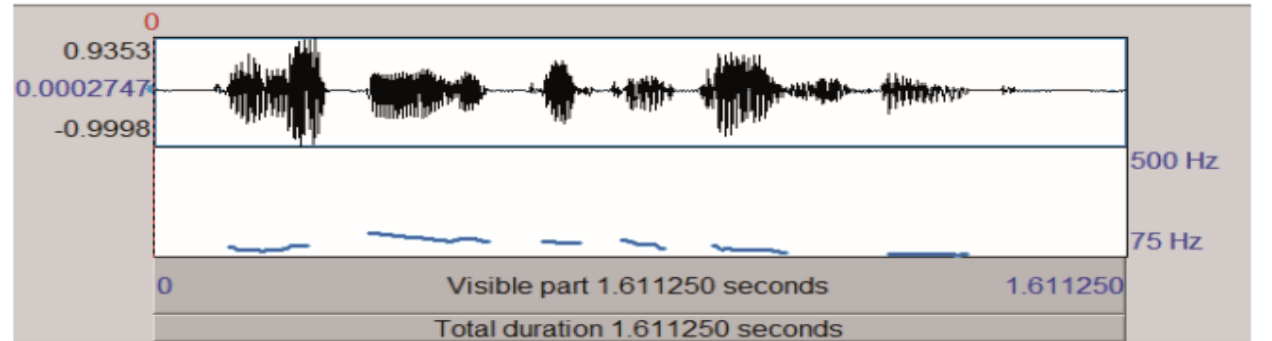
Fig.3 Pitch contour for